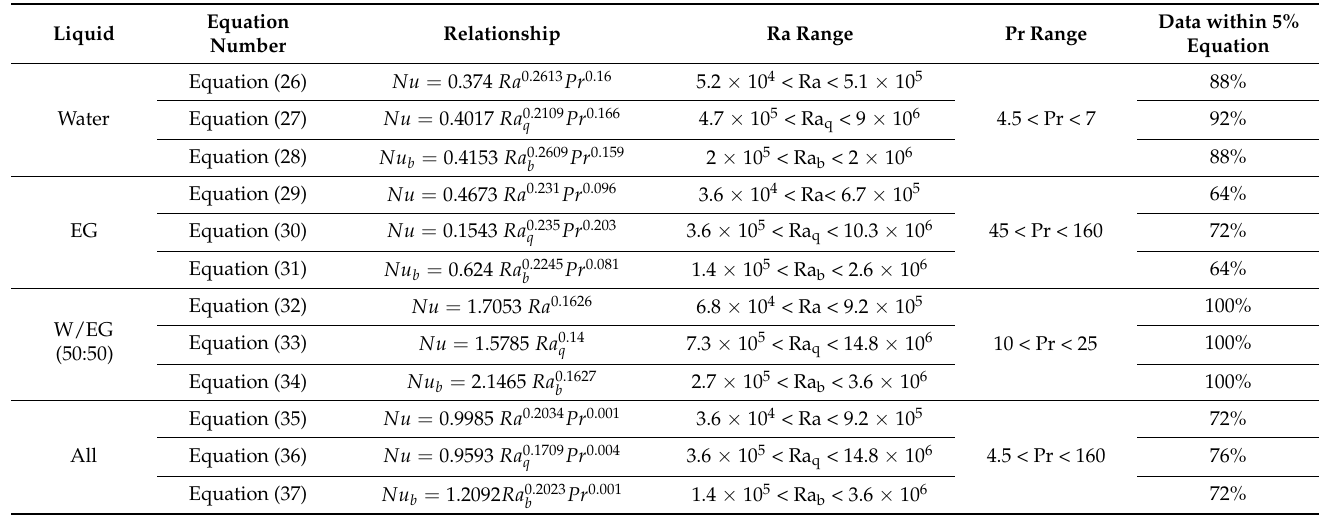
Table 5. The developed empirical heat transfer correlations for a horizontal cylinder.